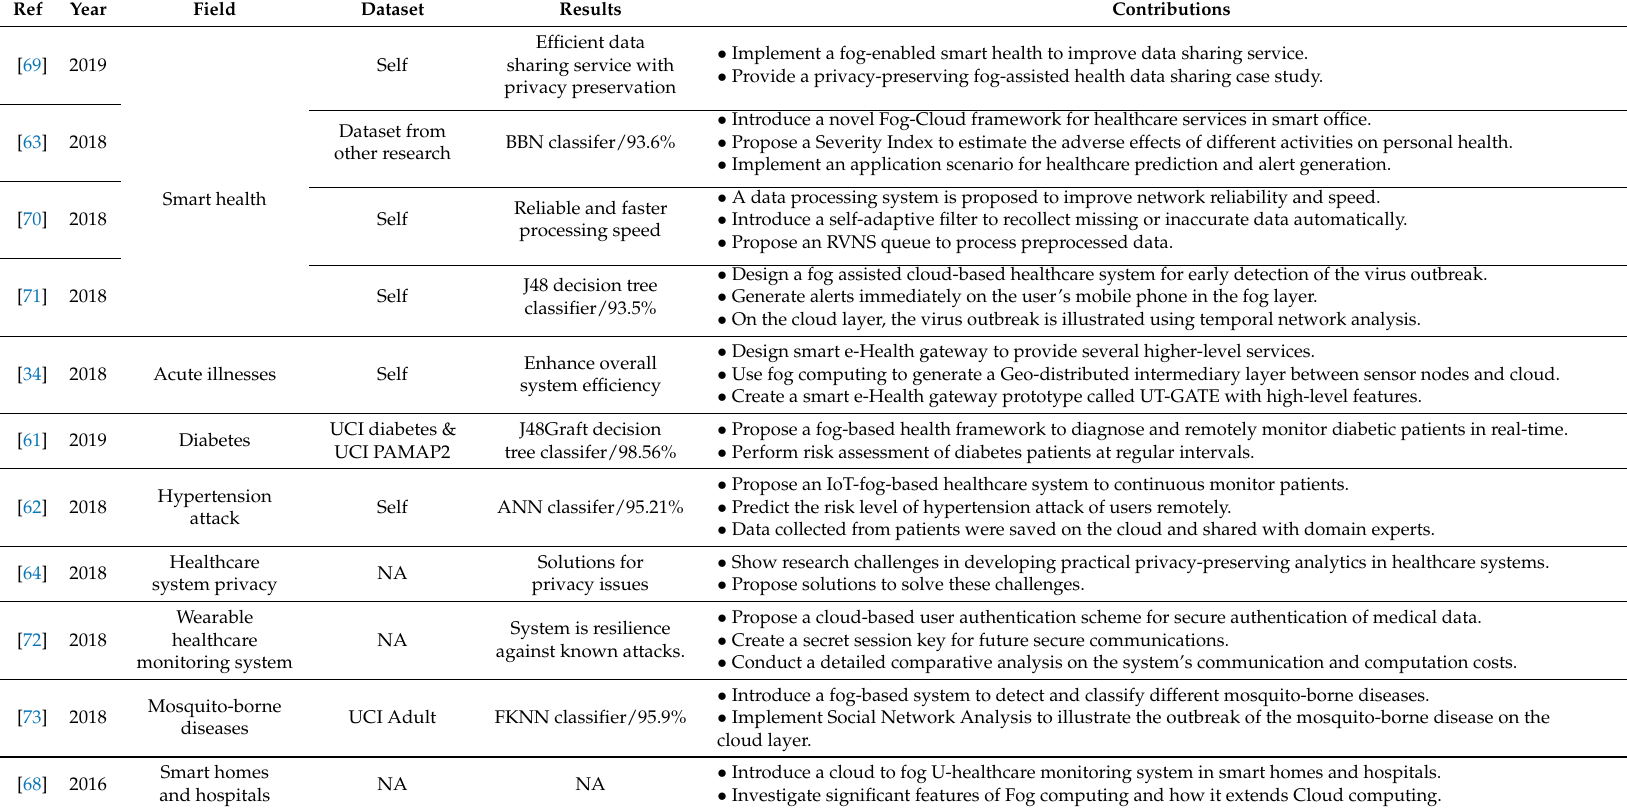
Table 5. Summary of the research field, dataset, results and main contributions from recent fog-based healthcare studies.